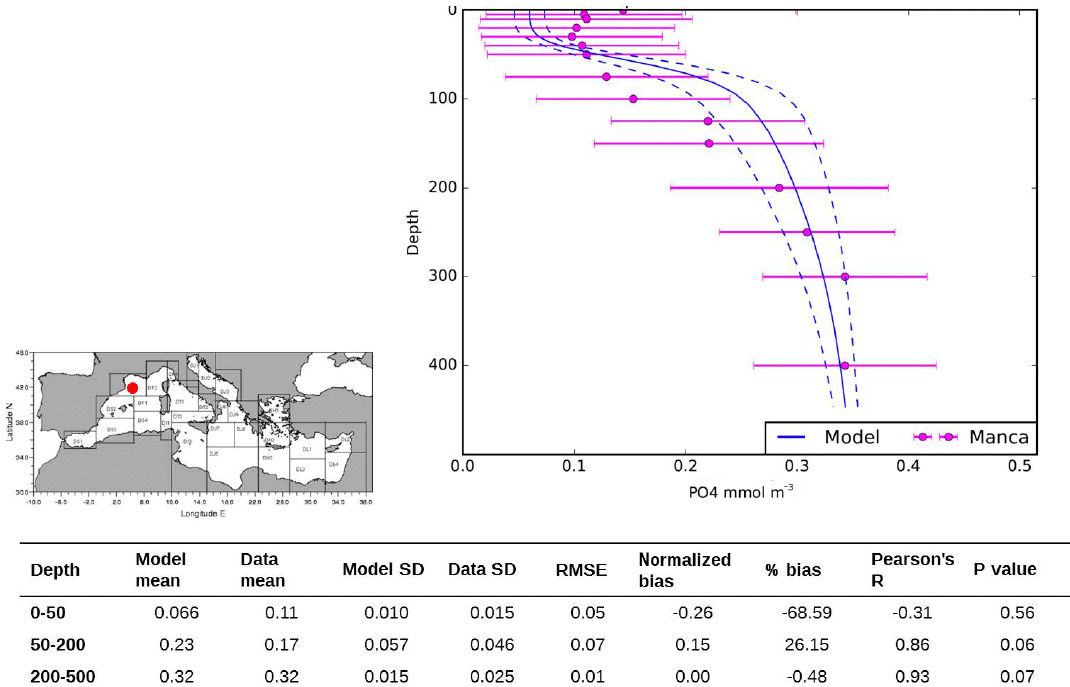
Figure A5. Annually averaged PO 4 vertical profile in the Gulf of Lion sub-basin (see map and Manca et al., 2004) and statistical indicators over different depth. Model values are shown with the blue line (2005 average, Ntot simulation from Richon et al., 2017) and measured values from Manca et al. (2004) are in pink. Horizontal bars and dashed lines indicate the spatial SD of observations and model results respectively.